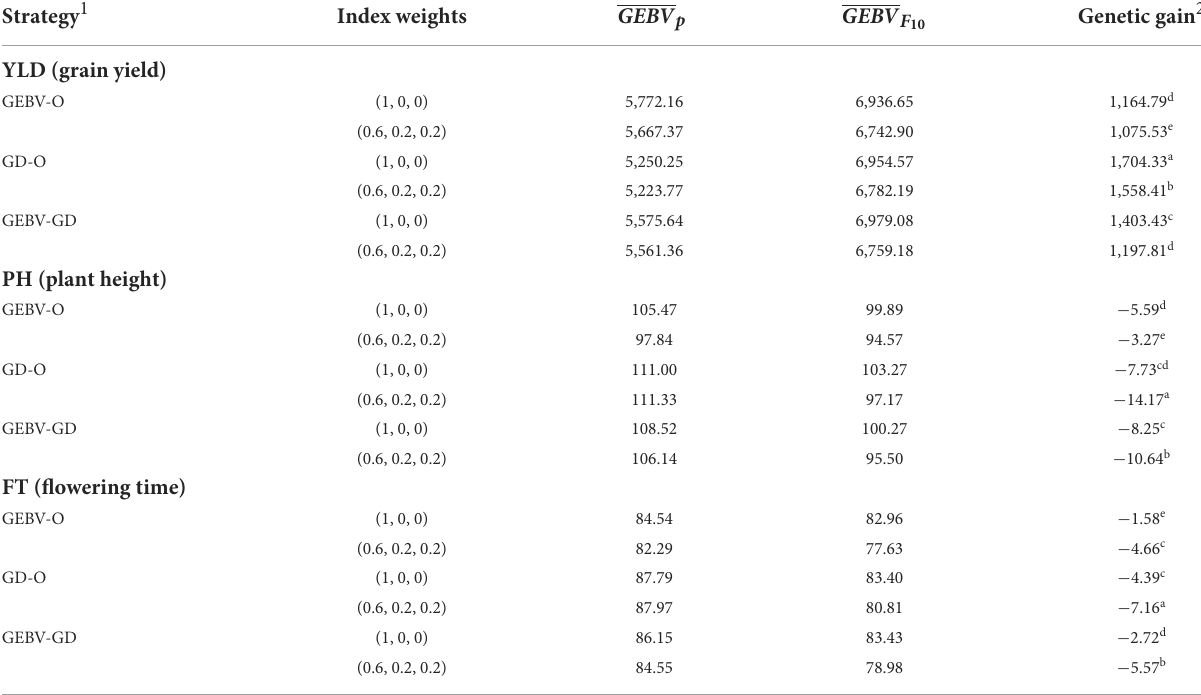
TABLE 2 GEBV average for parental lines, GEBV average for F 10 inbred lines, and genetic gain for the tropical rice dataset. Strategy 1 Index weights GEBV p GEBV F